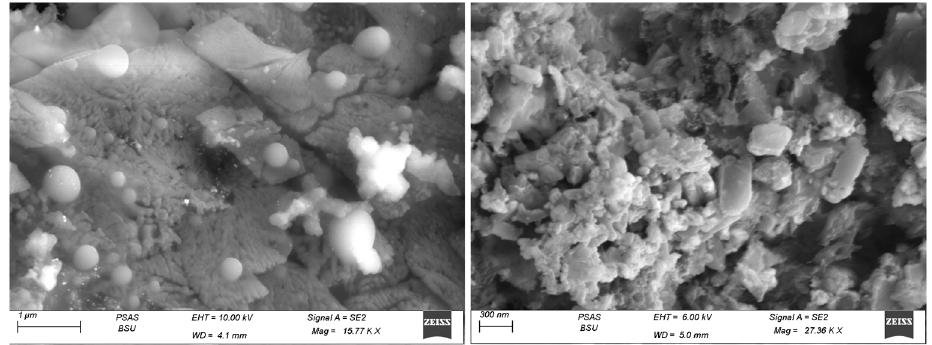
Figure 3. Surface morphology of MTX-GNPs by SEM.